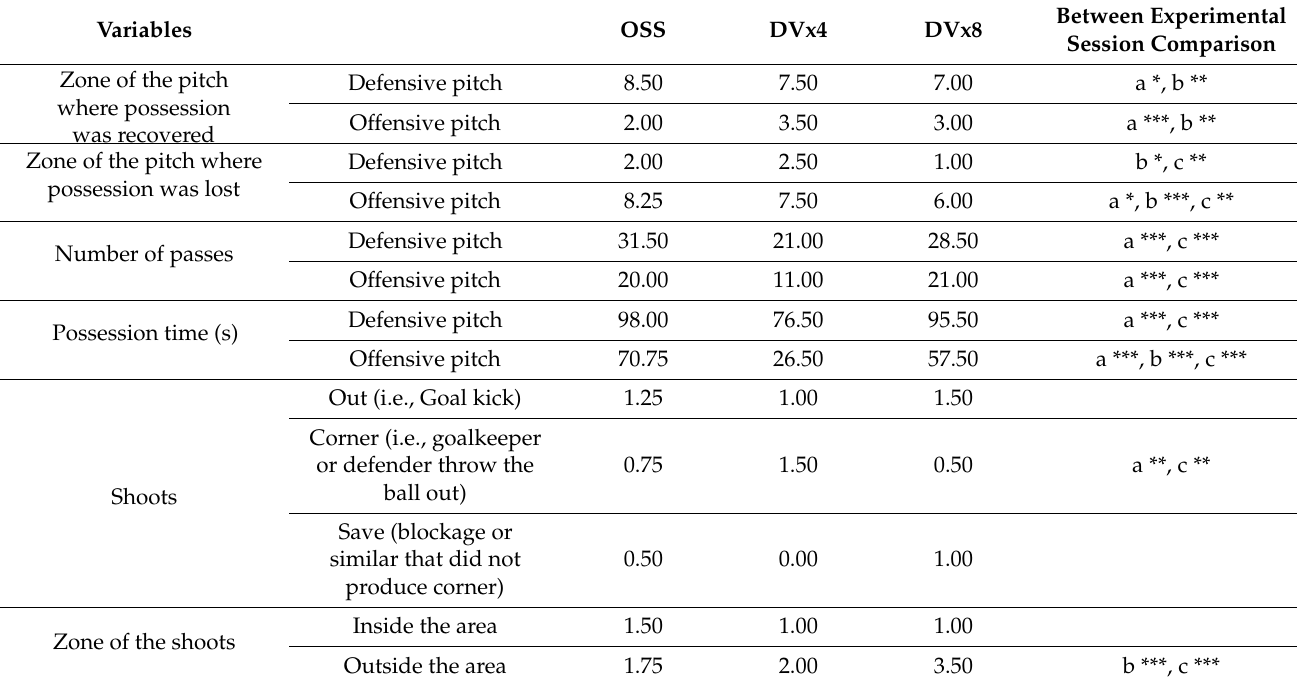
Table 3. Analysis of tactical behavior during the large-sided games. A comparison between experi- mental